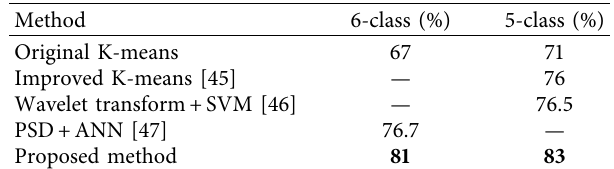
Table 4: Comparison of SSE values of the two algorithms after the first iteration.